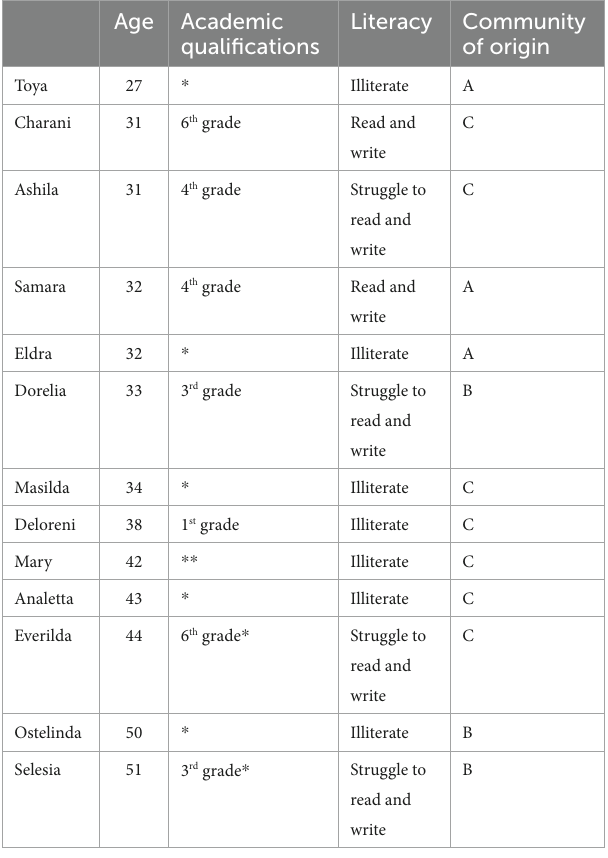
TABLE 1 Descriptive information about the